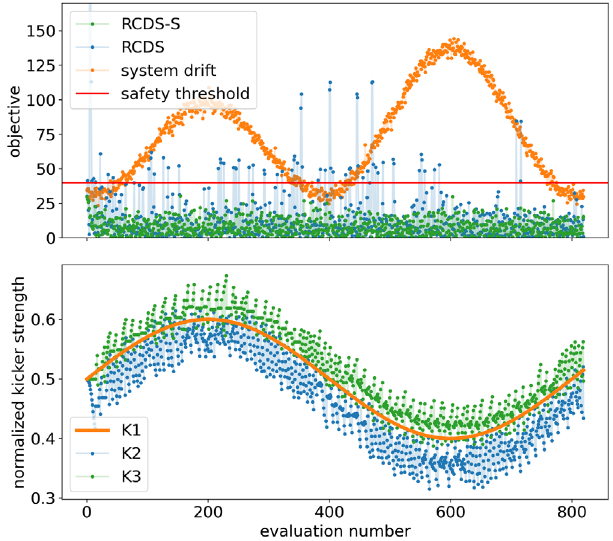
FIG. 9. RCDS-S for kicker-bump matching in simulation. Top plot: orange dots show the objective drift caused by the modulated kicker strength at the initial solution. Blue dots denote the objective function during optimization by the RCDS algorithm while green dots show the performance of RCDS-S. The red horizontal line shows the safety threshold. Bottom plot: orange curve shows the modulation on K1, and the other two dotted curves visualize the evolution history of the variables tuned by